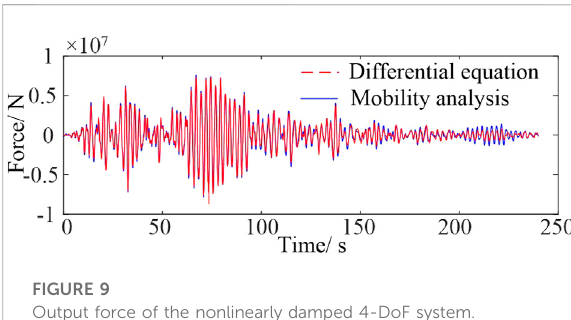
FIGURE 9 Output force of the nonlinearly damped 4-DoF